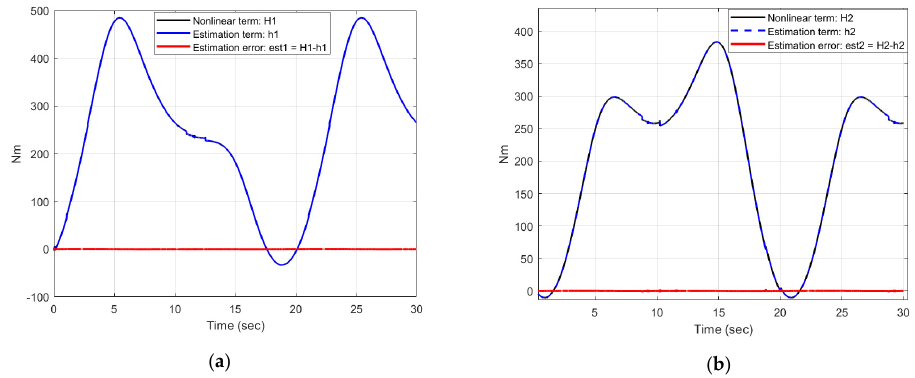
Figure 8. Time trajectories of estimation errors of Syn-TDE-NFTSMC of joint 1 ( a ) and joint 2 ( b ).